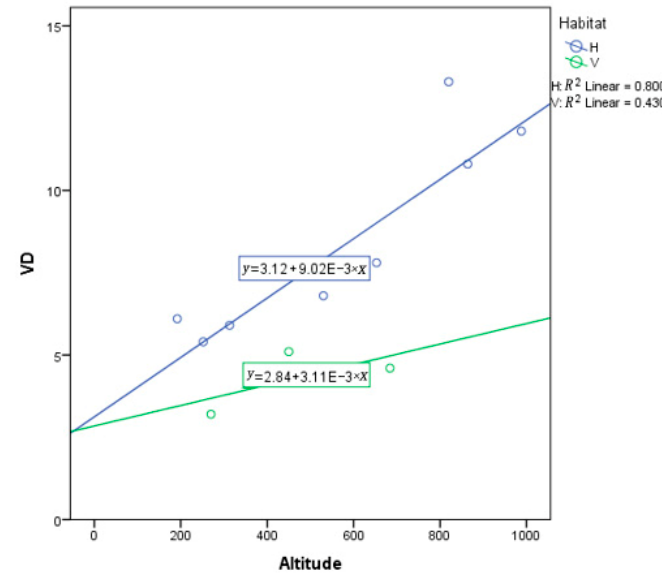
Figure 9. Analysis of covariance (ANCOVA) between vein density (VD) and altitude in hillside and valley habitats. Each dot represents a sampling site in China. E represent ten to the power of N.